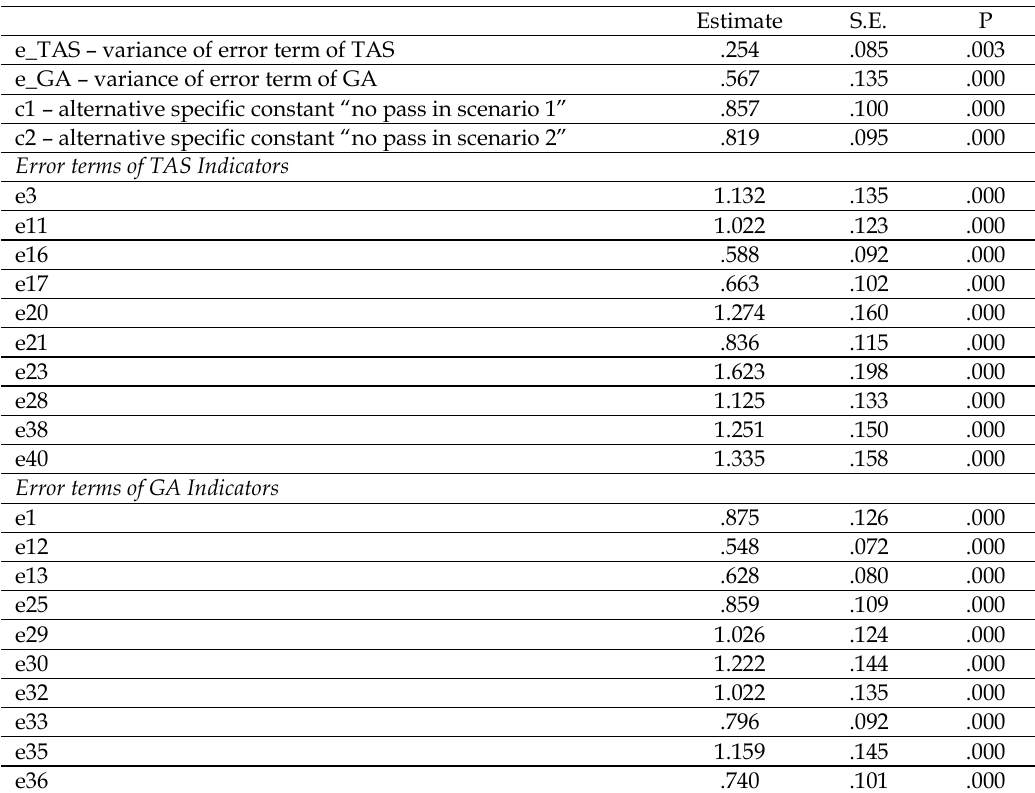
Table 7. Variance of the error terms